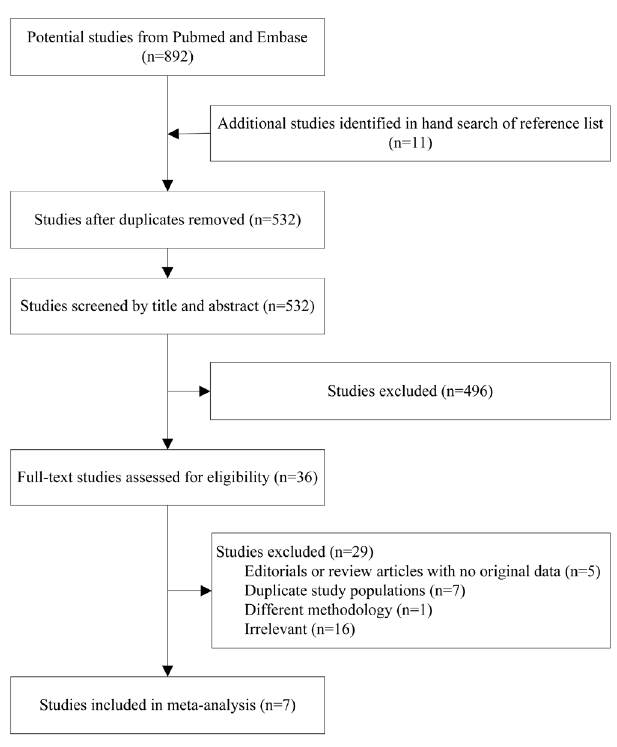
Figure 1. Flowchart of Study Identification and